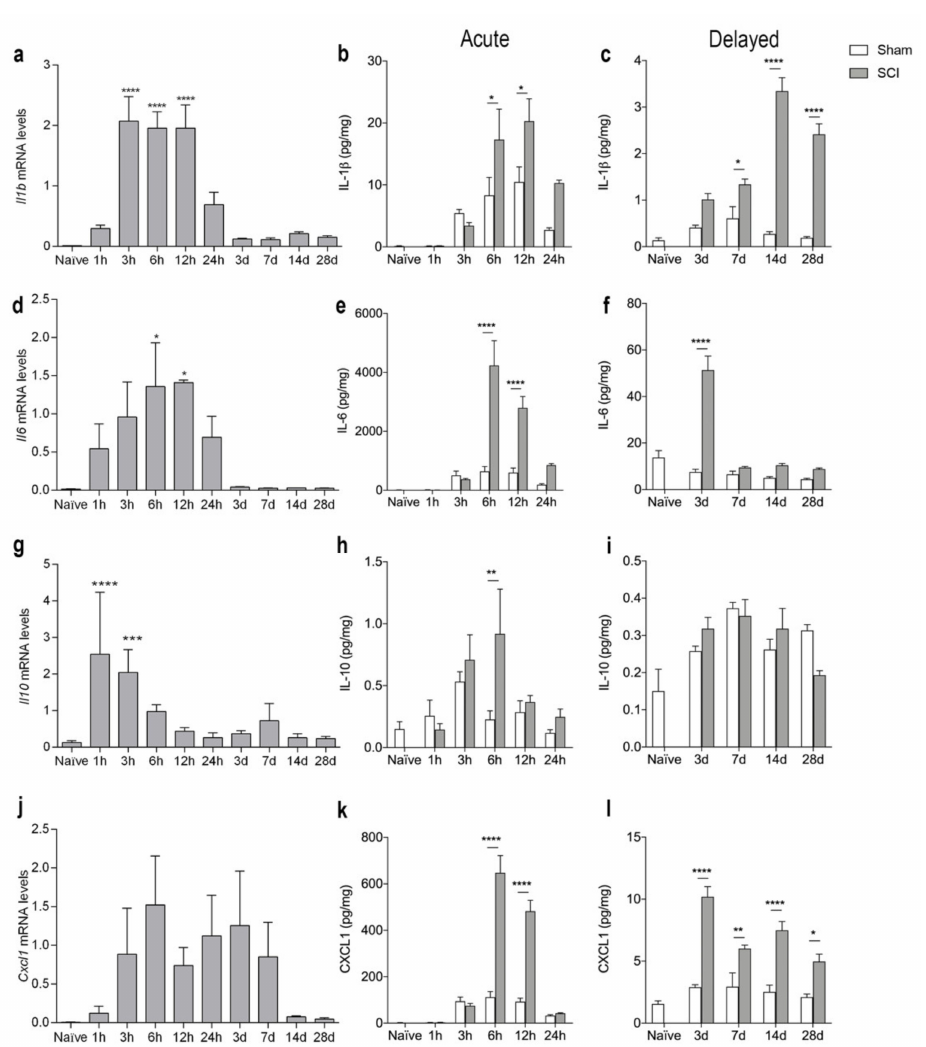
Figure 5. Temporal expression of inflammatory cytokines after SCI. ( a – c ) Temporal expression of Il1b mRNA (( a ), p < 0.0001, Time: F 9,39 = 17.04) and IL-1 β levels in the acute phase (( b ), Interaction: F 5,47 =